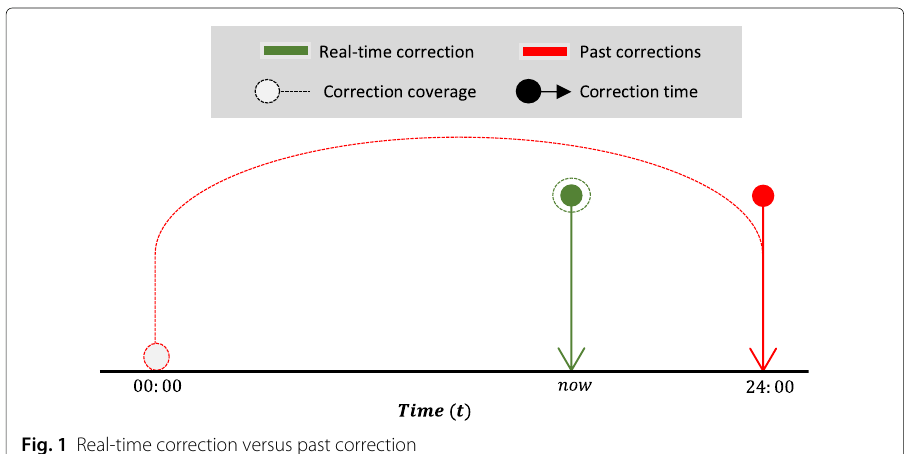
Fig. 1 Real-time correction versus past